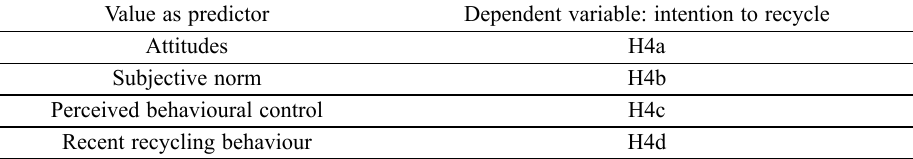
Table 2. Detailed hypotheses of attitude, subjective norm, perceived behavioural control and recent recycling behaviour as predictors of intentions to